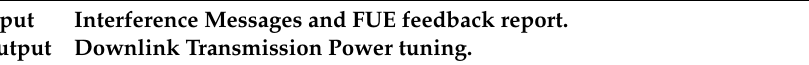
Table 1. Active Power Control